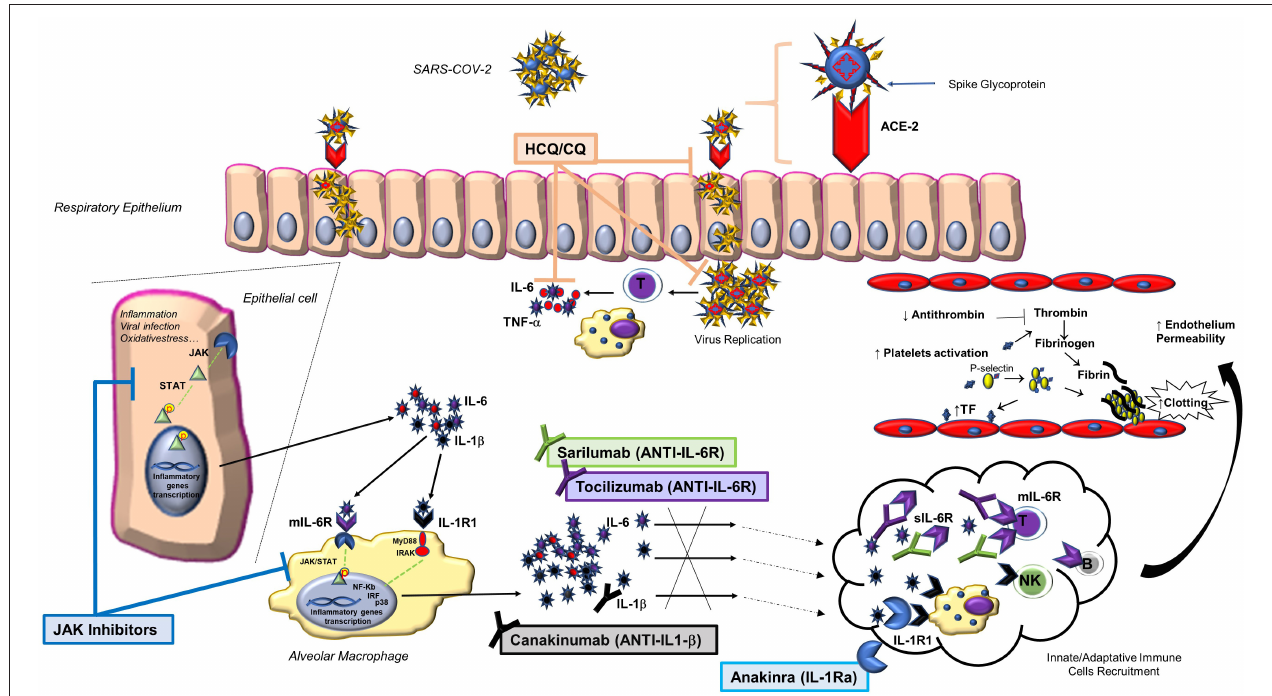
FIGURE 1 | Main biological pathways activated by SARS-CoV-2 infection and treatment strategies to block them through anti-rheumatic drugs. Following SARS-CoV-2 binding to the ACE-2 host receptor via the spike glycoprotein, a series of events occur within the affected cell, including the activation of the JAK/STAT pathway and the release of pro-inflammatory cytokines, such as IL-1 β and IL-6. This finding, together with the observation that IL-6 is largely involved in the lung damage that may complicate the infection, led to include the use of some anti-rheumatic drugs (anti-IL6: tocilizumab and sarilumab; antimalarials: chloroquine and hydroxychloroquine) in various treatment protocols. Other anti-rheumatic drugs may be of interest in the treatment of COVID-19 (IL-1 and JAK inhibitors). ACE-2, angiotensin-converting enzyme 2; CQ, chloroquine; HCQ, hydroxychloroquine; IL-1Ra, IL-1 receptor antagonist; IL-1R1, type 1 IL-1 receptor; JAK, Janus kinase inhibitor; mIL-6R, transmembrane IL-6 receptor; NK, natural killer cell; p, phosphate; SARS-CoV-2, severe acute respiratory syndrome coronavirus 2; sIL-6R, soluble IL-6 receptor; STAT, signal transducers and activators of transcription; TF, tissue factor; TNF, tumor necrosis